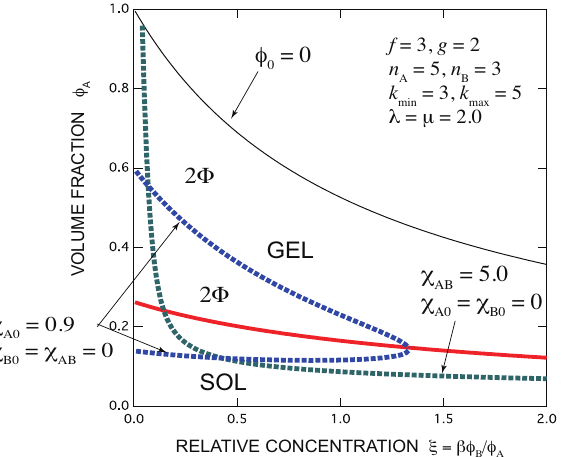
Figure 9. Phase diagram of a mixture of trifunctional A molecules and bifunctional B molecules in a solvent, whose functional groups are completely miscible in a range of multiplicity between 3 and 5. Solution of A molecules has SGT without B molecules, whose gel concentration monotonically decreases by mixing B molecules. Spinodal line for an interaction parameter χ A , B = 5.0 between A- and B molecules in a good solvent (green broken line) and in a solvent poor to A molecules χ A ,0 = 0.9 (blue broken line) are also drawn. For the latter, there is a critical B concentration above which the solution becomes uniform.